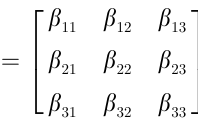
14 10 4.6 (SD 1.3) 0.06 0.06 5.874 44.63 33.333 33.333 29.385 29.363 0.001 0.1 3.544 31.9